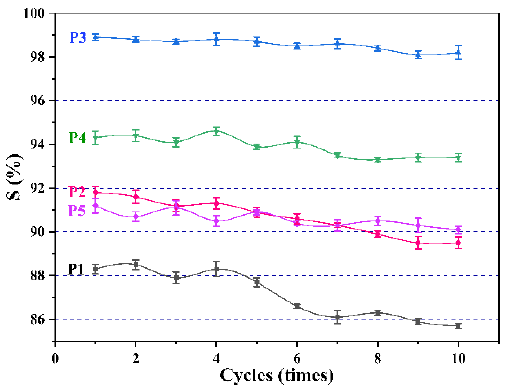
Figure 9. Changes in separation efficiency of different membranes over ten cycles.